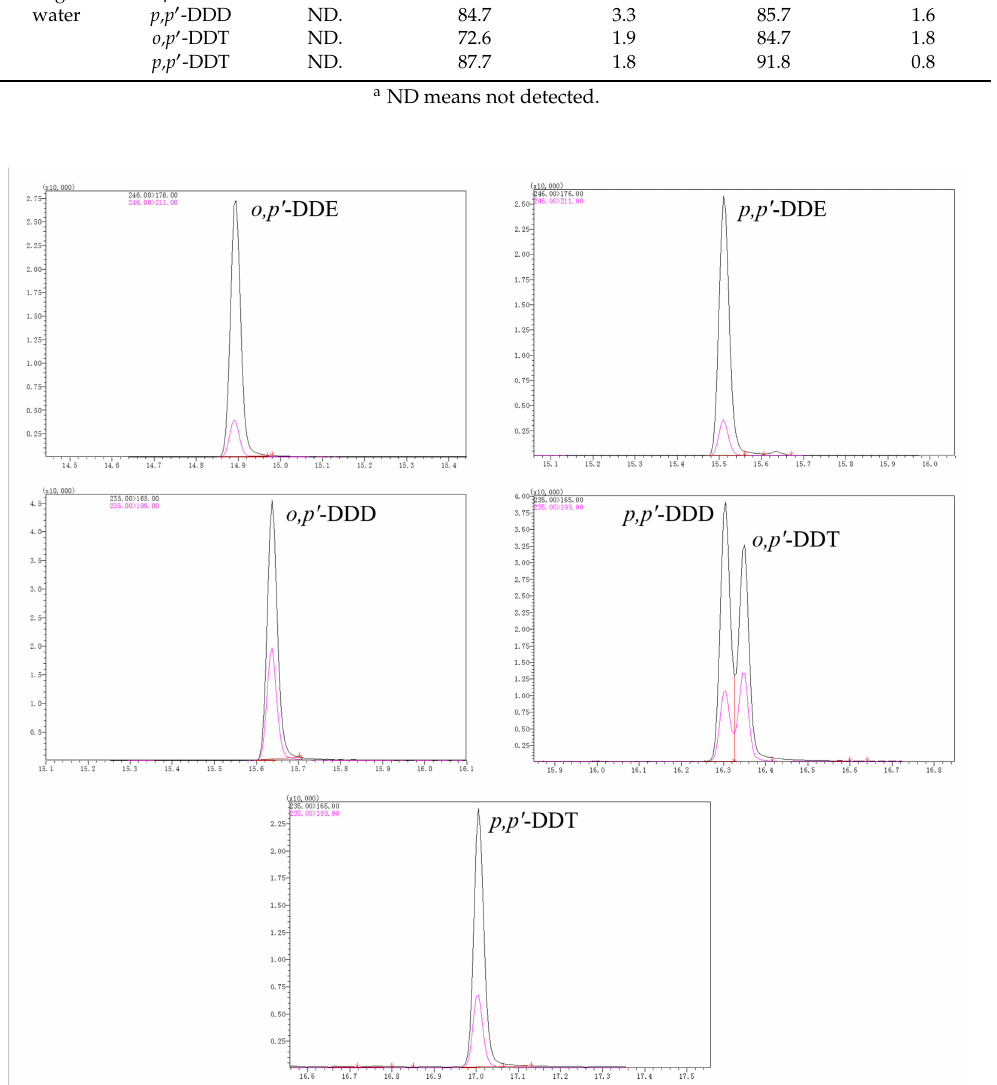
Figure 4. Extracted total ion chromatograms obtained by the MM / ZIF-8 / IL-based method for DDTs from river water spiked at 10 µ g L − 1